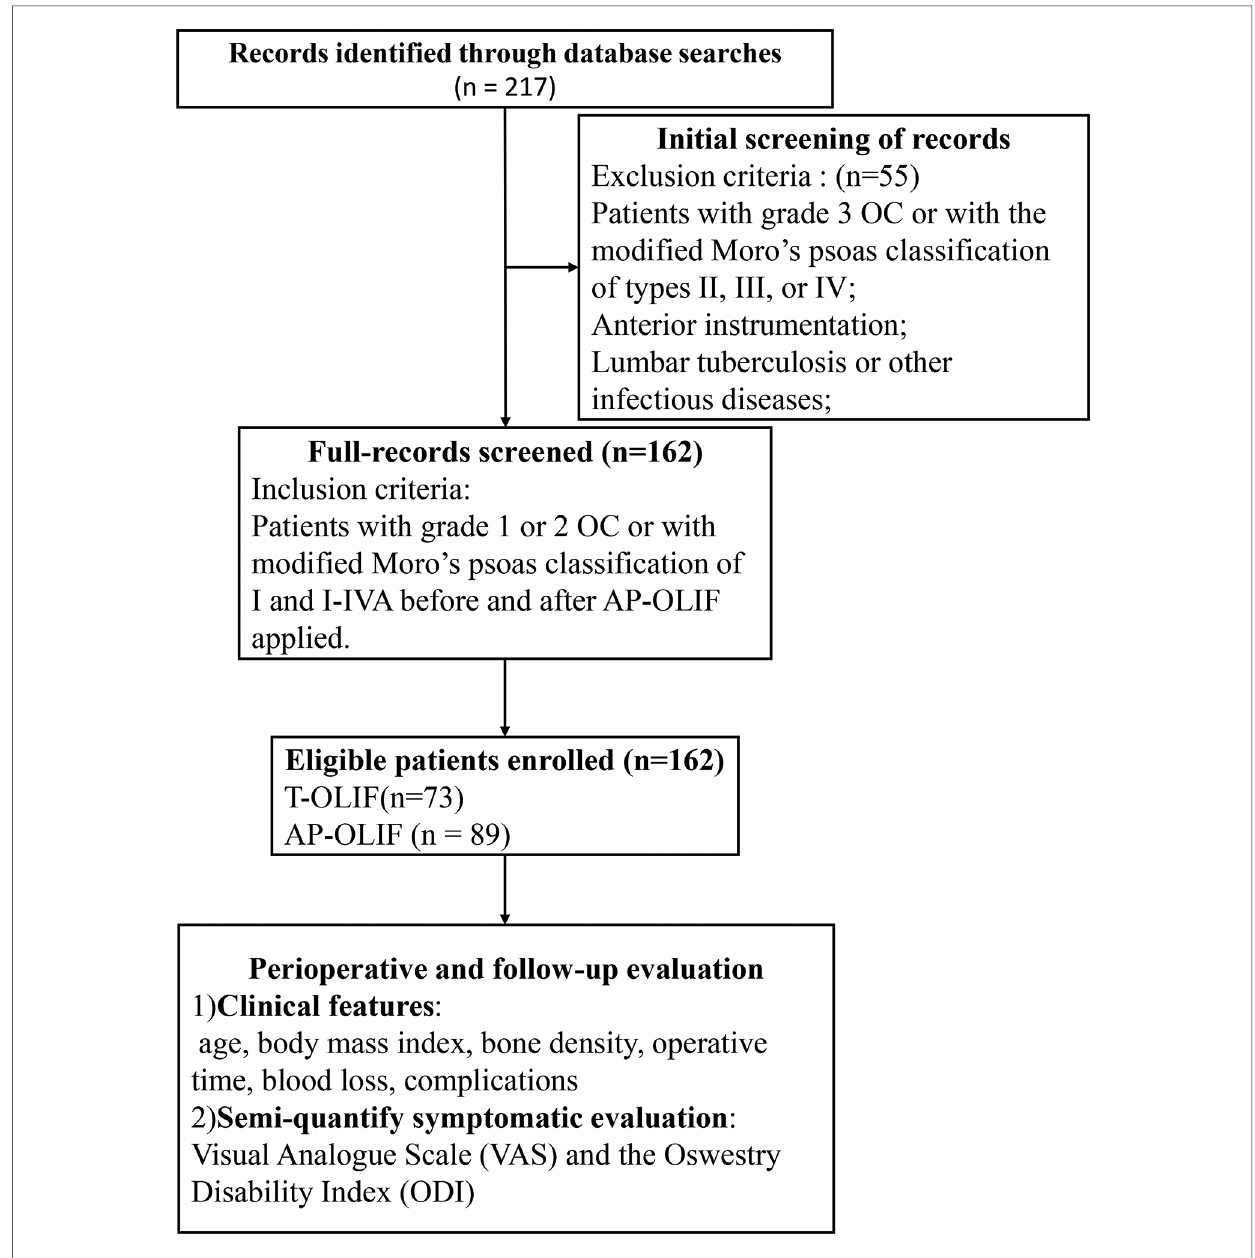
FIGURE 8 Flow chart of the study selection and tracking